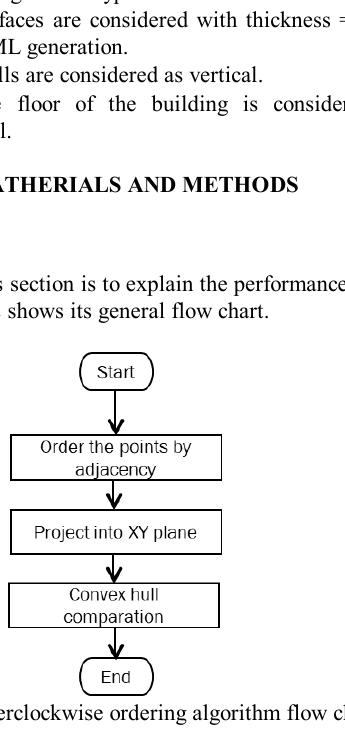
Figure 4. Schema of adjacency of two points using two common